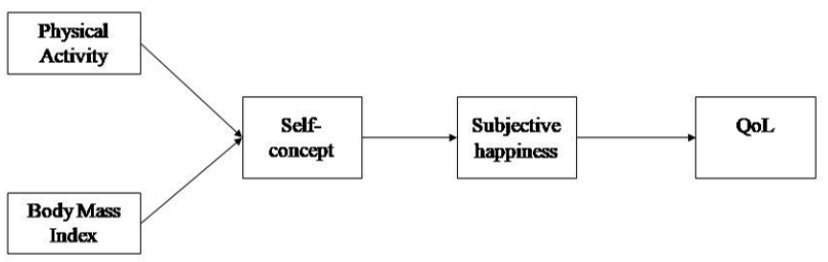
Figure 1. Hypothesized model in adolescents. Note. QoL: Quality of life.